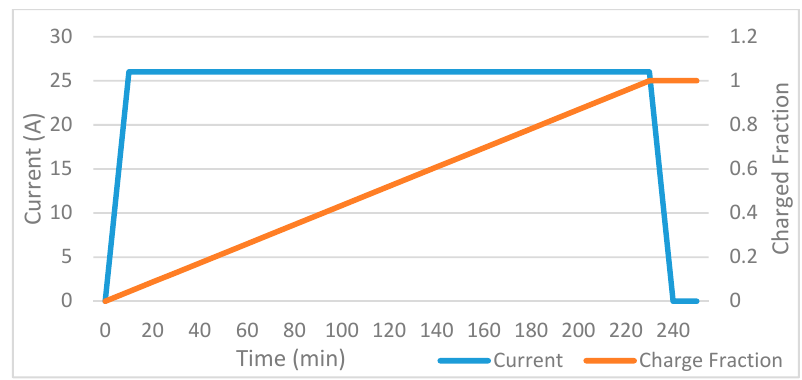
Figure 5. Current vs. battery charging fraction for Tesla Model S measured by authors.